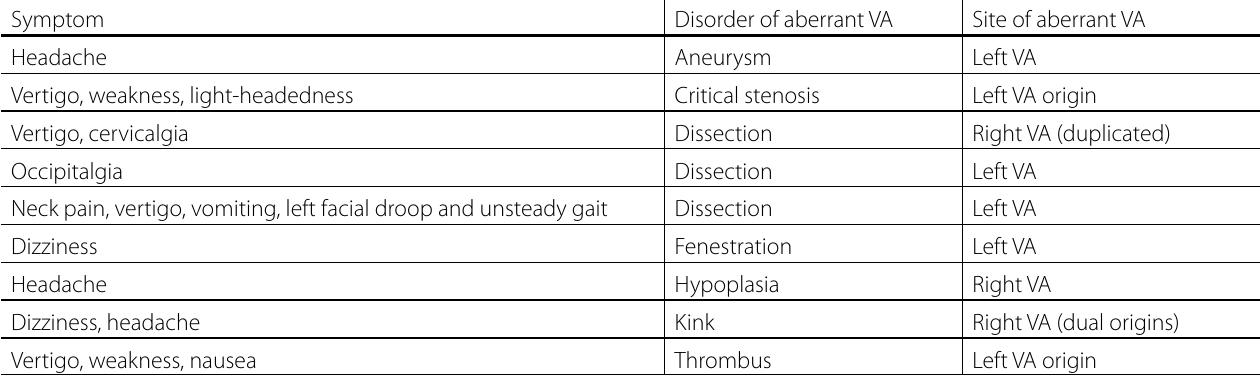
Table 1. Symptoms related to aberrant vertebral artery disorder in 9 patients.